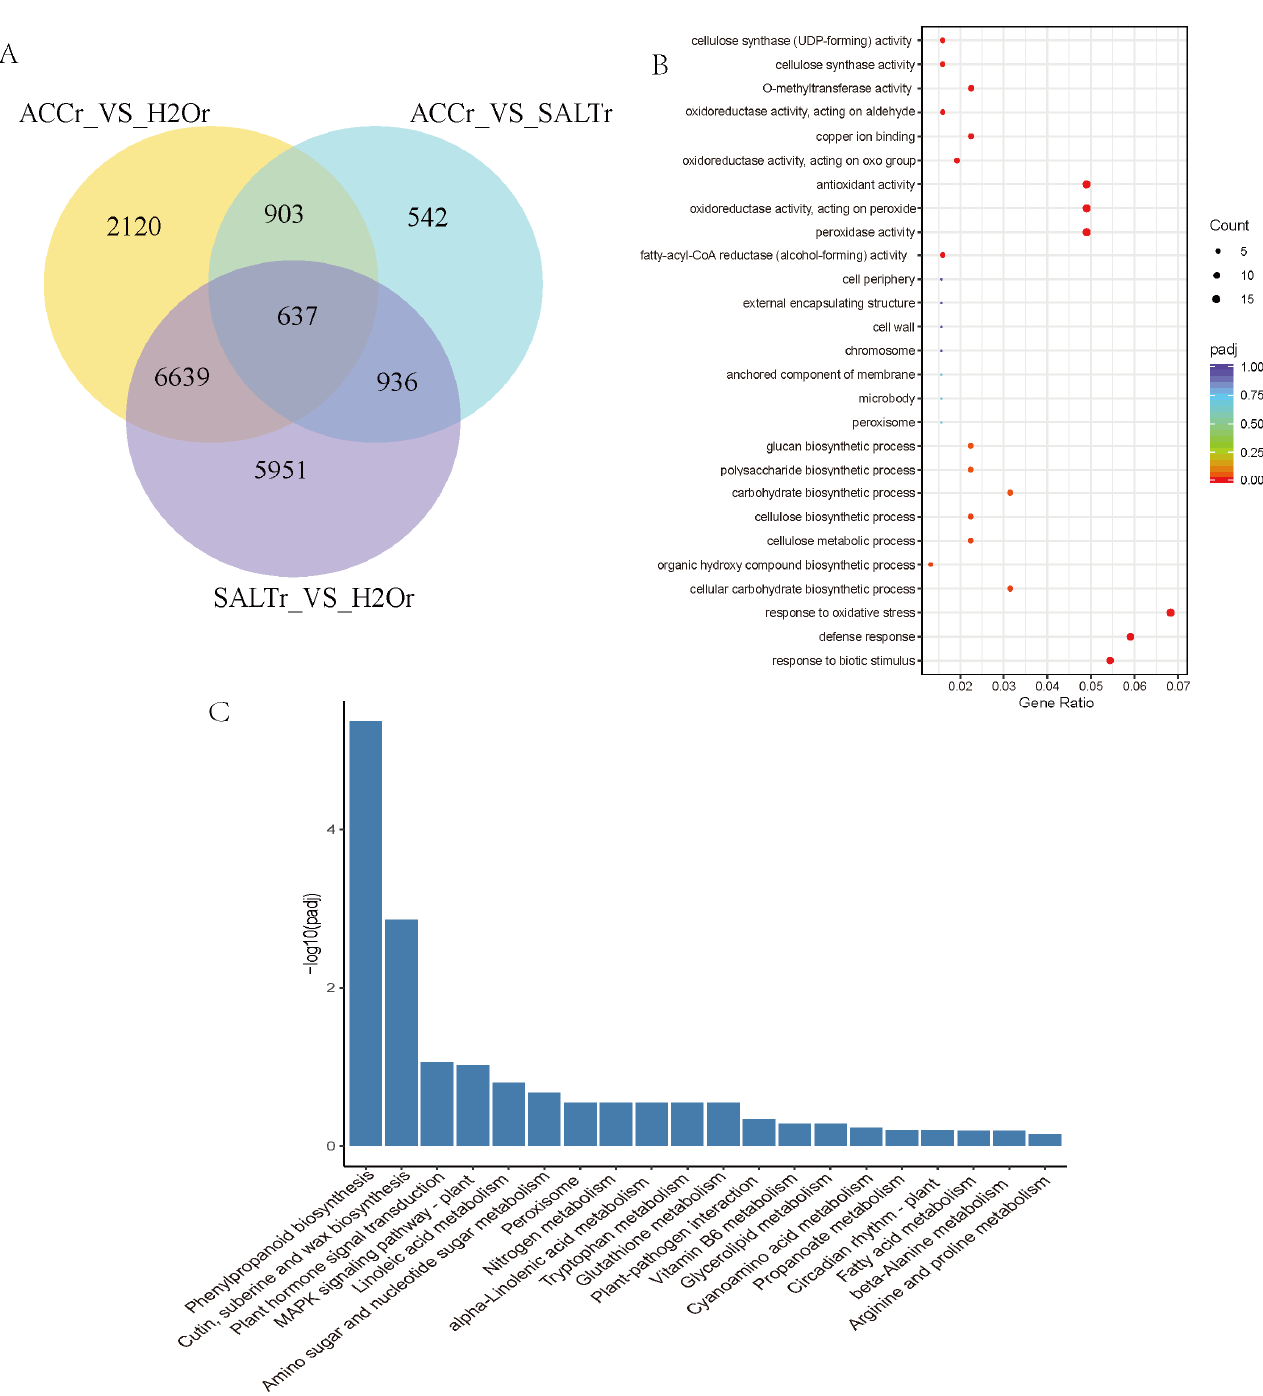
Figure 1. Multiple comparison of H2Or-vs-SALTr, H2Or-vs-ACCr, and SALTr-vs-ACCr. ( A ) Venn diagrams of DEGs in multiple comparisons. ( B ) GO enriched scatter plot of DEGs in ethylene and salt responses of quinoa. Rich factor refers to the ratio of the gene number enriched in the pathway to the number of annotated genes. The bigger the Rich factor, the more significant the enrichment is. The padj value is the corrected p -value after multiple hypotheses testing, which ranges from 0 to 1. The closer to zero, the more significant the enrichment is. ( C ) The top 20 KEGG enrichment analyses of DEGs in ethylene and salt responses of quinoa. The Y-axis indicates the number of DEGs, and the X-axis shows the processes/components in different functions.